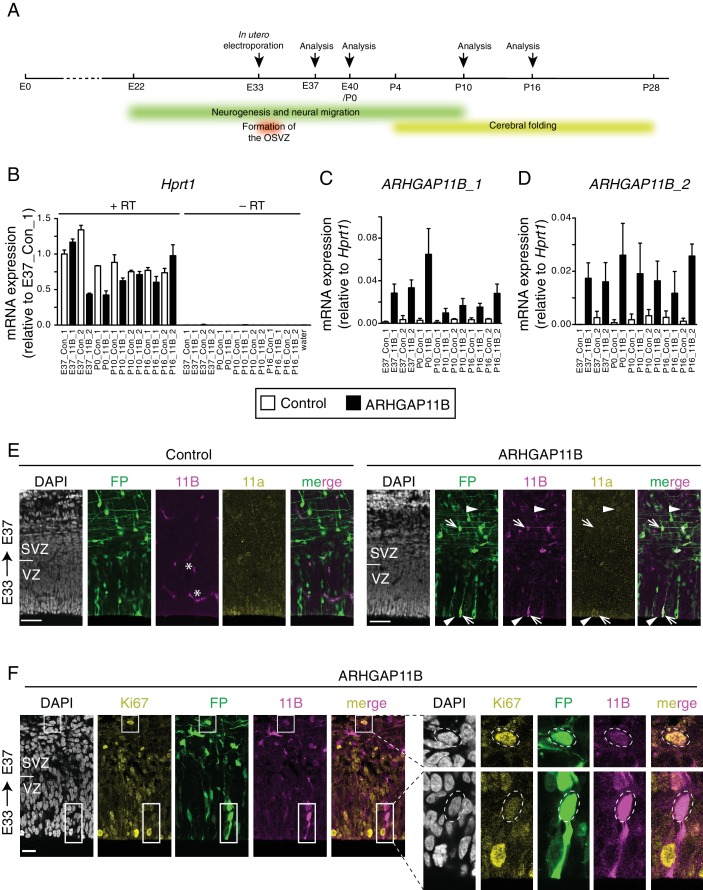
Forced expression of ARHGAP11B in the developing ferret neocortex.(A) Scheme of ferret neocortex development and experimental approach. ARHGAP11B was expressed in developing ferret neocortex by in utero electroporation at E33, when the OSVZ begins to form. Analyses were performed at E37, E40/P0, P10 and P16. Analysis of cortical progenitors was performed at E40/P0, analysis of post-mitotic cells at E40/P0, P10 and P16, and analysis of brain size and neocortex morphology at P16. (B–D) mRNA expression analysis by RT-qPCR at E37, P0, P10 and P16. RNA was isolated from cryosections of paraformaldehyde-fixed brain tissue following ferret in utero electroporation at E33. Expression of the housekeeping gene Hprt1 (B, note the lack of signal in the absence of reverse transcriptase (–RT)) was used for normalization of ARHGAP11B expression detected with two different primer pairs (C, ARHGAP11B_1; D, ARHGAP11B_2). Two control (Con_1, Con_2; white) and two ARHGAP11B-electroporated (11B_1, 11B_2; black) embryos were analyzed at each stage, except for P0 when one control and one ARHGAP11B-electroporated embryo were analyzed. Error bars represent SD of three PCR amplifications. (E, F) ARHGAP11B protein expression analysis by immunofluorescence. Ferret E33 neocortex was electroporated in utero with a plasmid encoding FP together with either a plasmid encoding ARHGAP11B or empty vector (Control), followed by analysis at E37. (E) Triple immunofluorescence for FP (green), ARHGAB11B (11B, magenta) and Arhgap11a (11a, yellow), combined with DAPI staining (white). Arrows, an ARHGAP11B+ FP+ cell that is Arhgap11a–; arrowheads, an Arhgap11a+ cell that is FP– ARHGAP11B–. Note that the exposure of images of ARHGAP11B staining in the control neocortex was longer than in the ARHGAP11B-electroporated neocortex, in order to show the lack of a specific signal in the control, where only unspecific signal at blood vessels was detected (asterisks). Images are single optical sections. Scale bars, 50 μm. (F) Triple immunofluorescence for FP (green), ARHGAB11B (11B, magenta) and Ki67 (yellow), combined with DAPI staining (white), upon electroporation of a plasmid encoding FP and a plasmid encoding ARHGAP11B. Images are single optical sections. Scale bar, 20 μm. Boxes (25 μm wide), indicating an ARHGAP11B-expressing BP (upper box) and an ARHGAP11B-expressing AP (lower box), are shown at higher magnification on the right. Dashed lines, cell bodies.